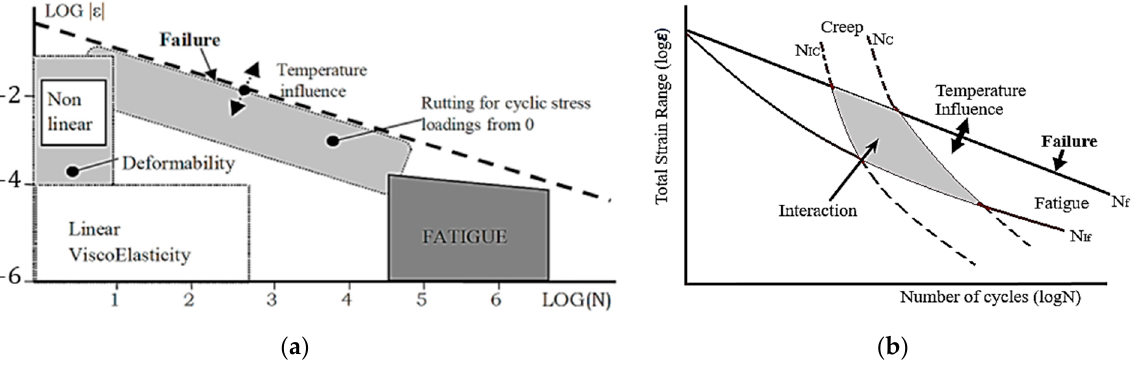
Figure 15. ( a ) Damage domains of bituminous mixtures ( ε —strain amplitude and N—number of cycles) and ( b ) fatigue and permanent deformation interactive damage for asphalt concrete (N C , N IC , N f , and N If failure lines for creep and fatigue domains).